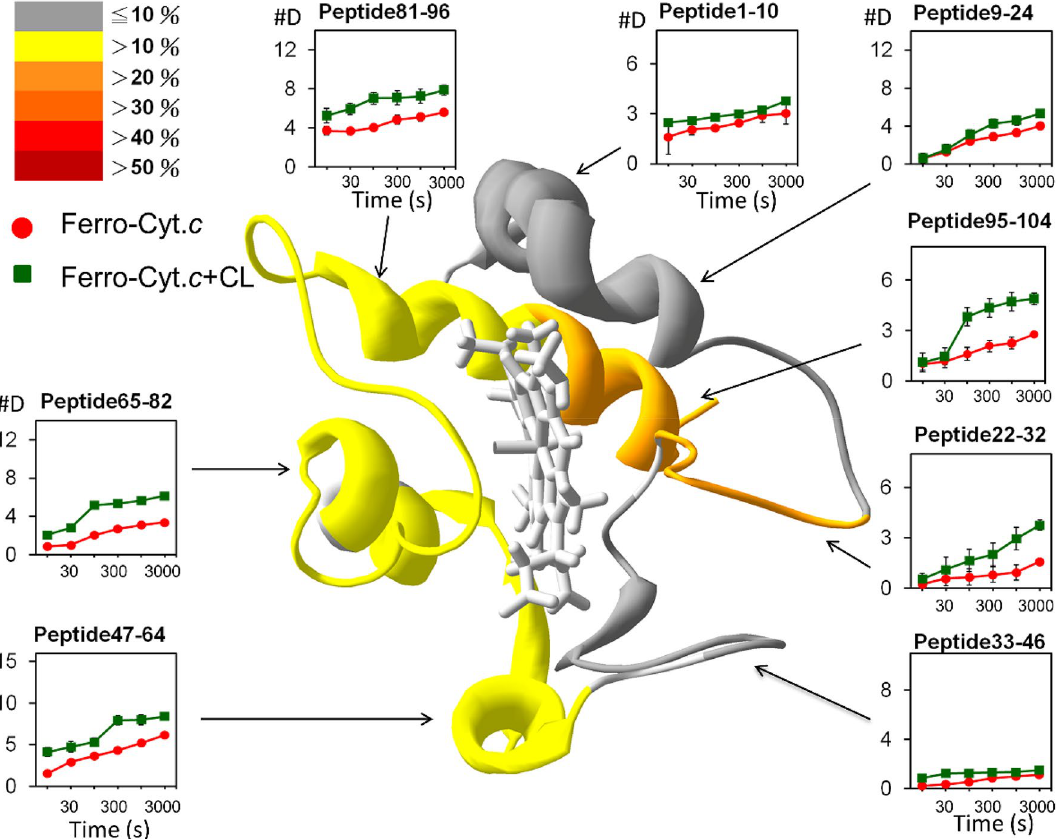
Figure 6. Deuteration level of ferrous cyt c (red) and the CL-bound ferrous cyt c (green) represented by peptide fragments. Enhancement of deuteration caused by CL binding is illustrated in percentages and displayed in different colors (scale is shown in the top-left corner). The time-course deuterium number in each peptide fragment with the corresponding region of cyt c is presented (the ribbon diagram shown in the center of the